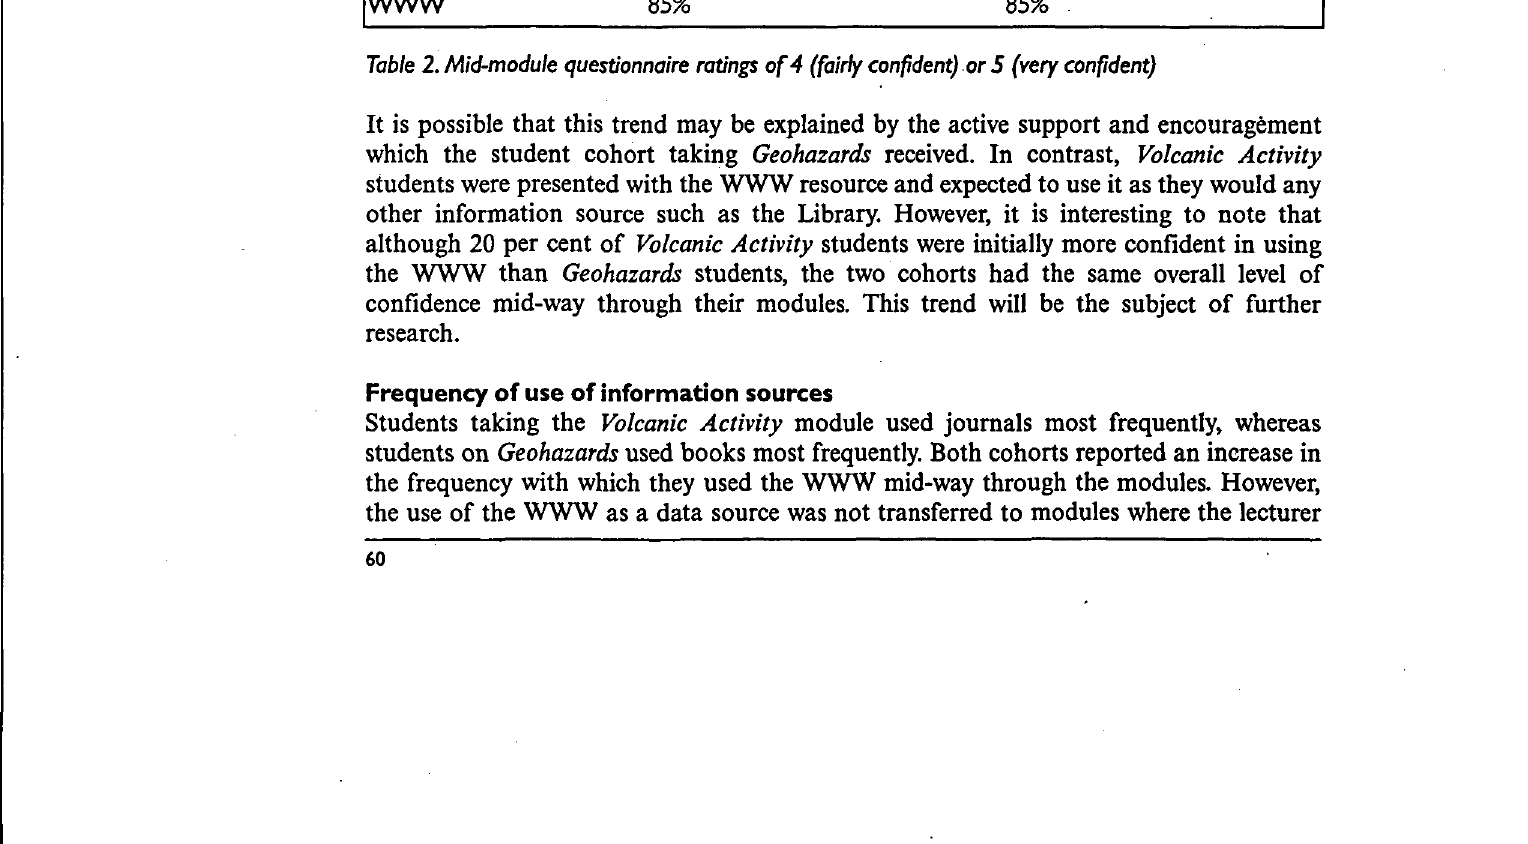
Table 2. Mid-module questionnaire ratings of 4 (fairly confident) or 5 (very